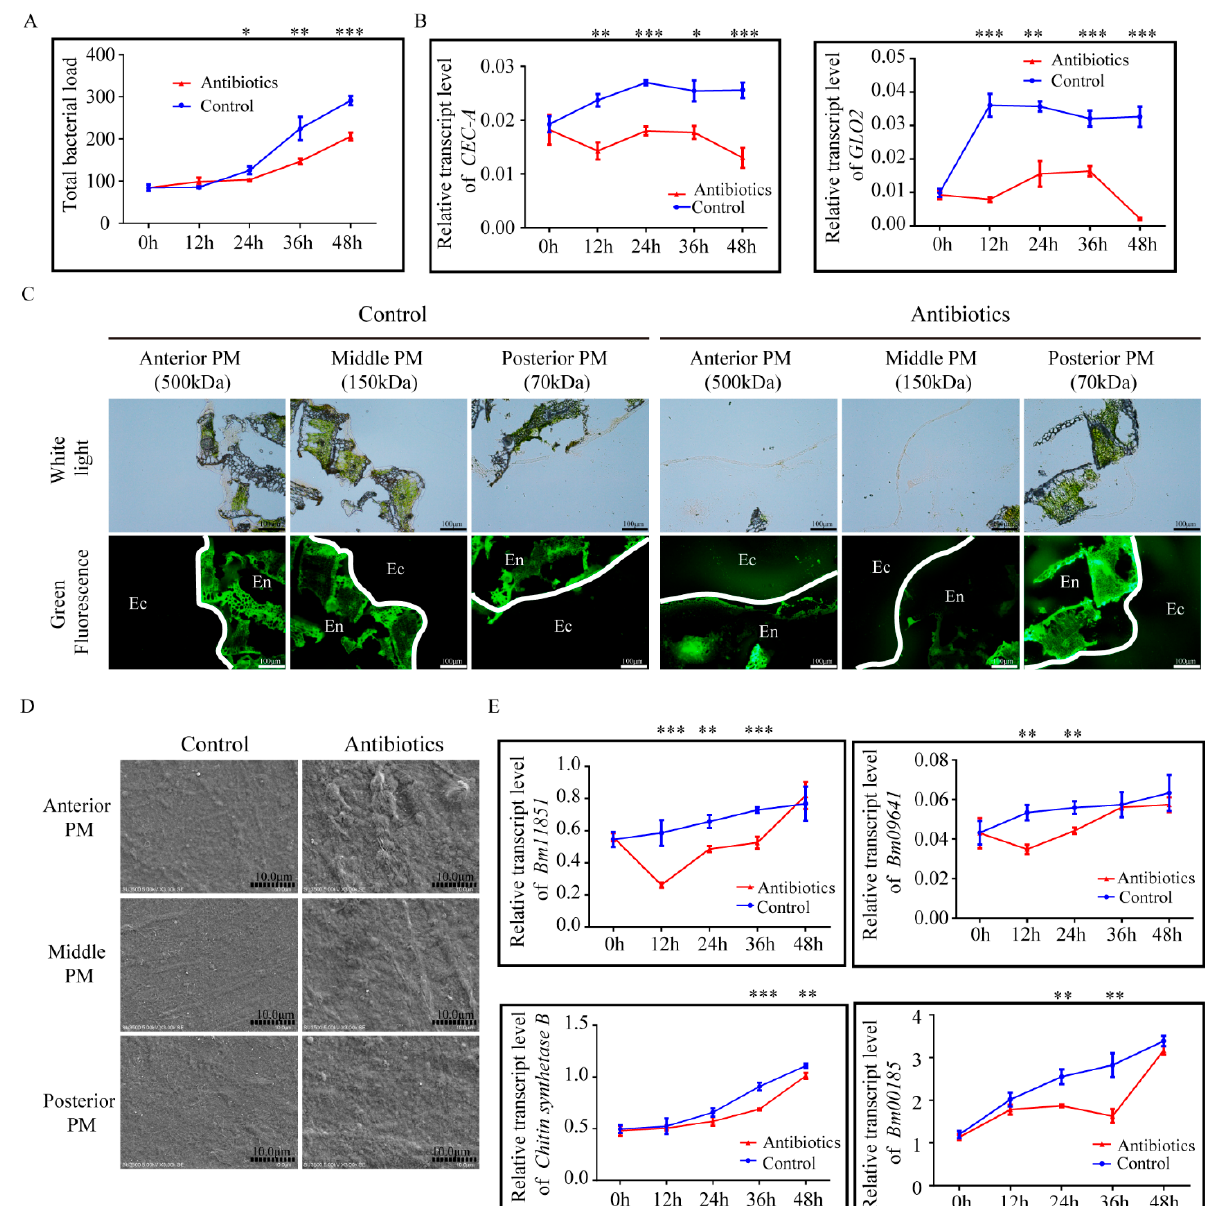
Figure 4. Antibiotic treatment compromises the integrity of the peritrophic matrix (PM) in the silkworm. ( A ) Bacterial load in the guts of control and antibiotic-treated silkworms detected by qRT-PCR using universal 16S ribosomal RNA (rRNA) primers. * p < 0.05, ** p < 0.01, *** p < 0.001. ( B ) Relative expression levels of antimicrobial peptide genes CEC-A and GLO2 in the midgut of control and antibiotic-treated silkworms. ( C ) Permeability of the anterior, middle, and posterior PM 24 h post-feeding with or without antibiotic supplementation evaluated by fluorescence microscope (200×). En, endoperitrophic space; Ec, ectoperitrophic space. White lines show the localization of the PM. ( D ) Morphological changes in the lumen side of the PM of control and antibiotic-treated silkworms was observed by scanning electron microscopy 24 h post-feeding (3000×). ( E ) Expression of four genes encoding components of the PM in the midguts of control and antibiotic-treated silkworms. ** p < 0.01, *** p < 0.001.